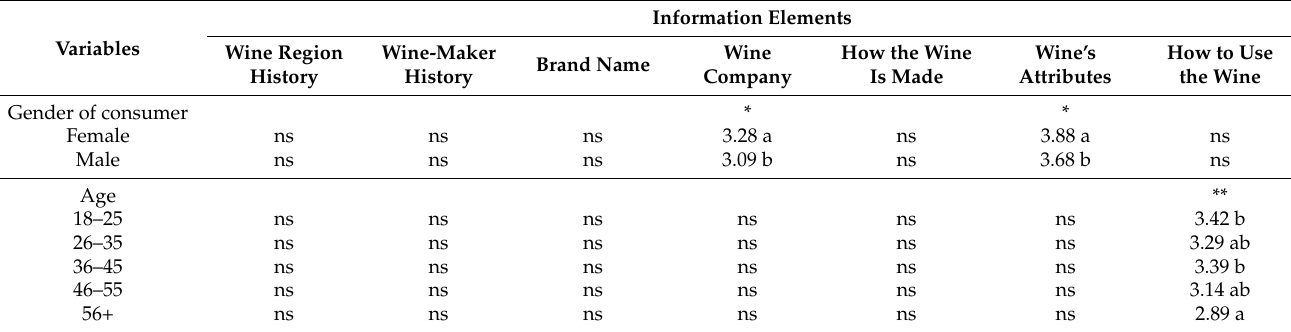
Table A2. Mean importance ratings for label information elements that varied with consumer